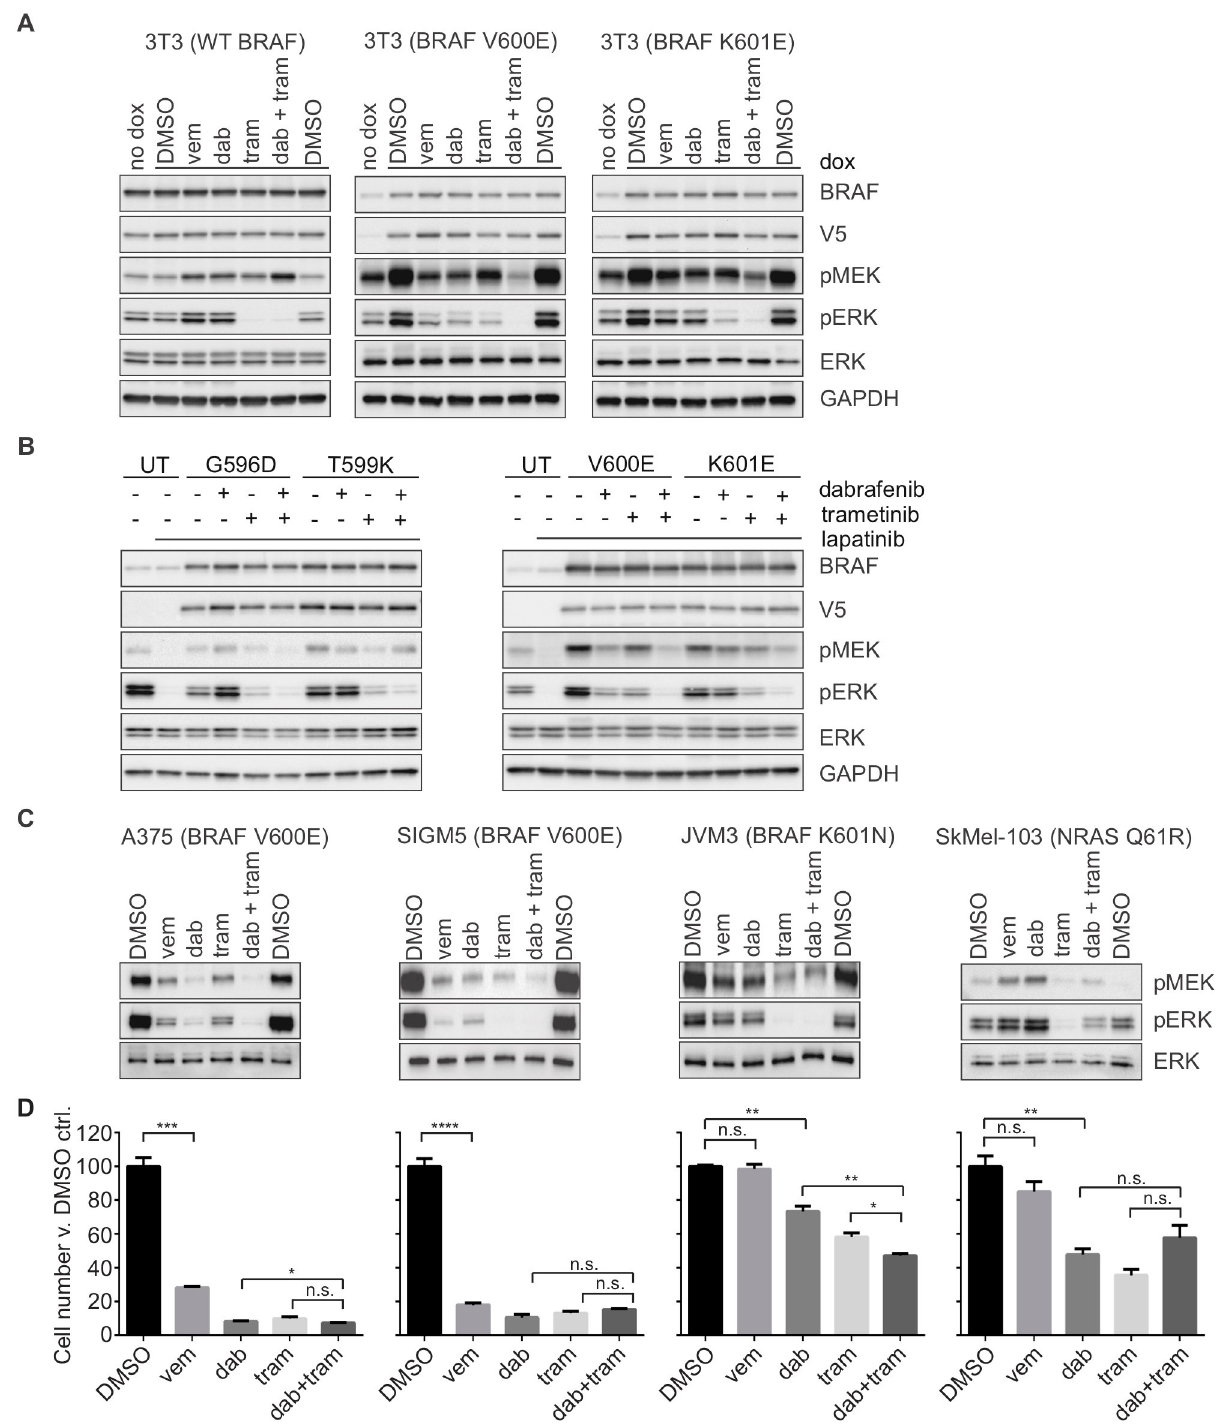
Fig 4. RAF plus MEK inhibition more potently inhibits phospho-ERK and proliferation in cells expressing BRAF K601 mutations than RAF inhibition alone. NIH-3T3 cells stably transfected with doxycycline-inducible BRAF mutants (WT, V600E and K601E) were plated in the presence of doxycycline (unless otherwise indicated) (A); SKBr3 cells, transiently transfected with V5-tagged BRAF mutants, pre-treated with lapatinib, as shown (B); and cell lines (C) were treated with vemurafenib (1000nM), dabrafenib (100nM, A and C, and 200nM, B), trametinib (20nM), or the combination of dabrafenib (100nM, A and C, 200nM, B) plus trametinib (20nM), as indicated, for 1 hour. (B). UT = untransfected. Expression and/or phosphorylation of the indicated proteins were assessed by immunoblot. D. Cell lines, as in C, were plated in 6-well dishes and the indicated drugs for